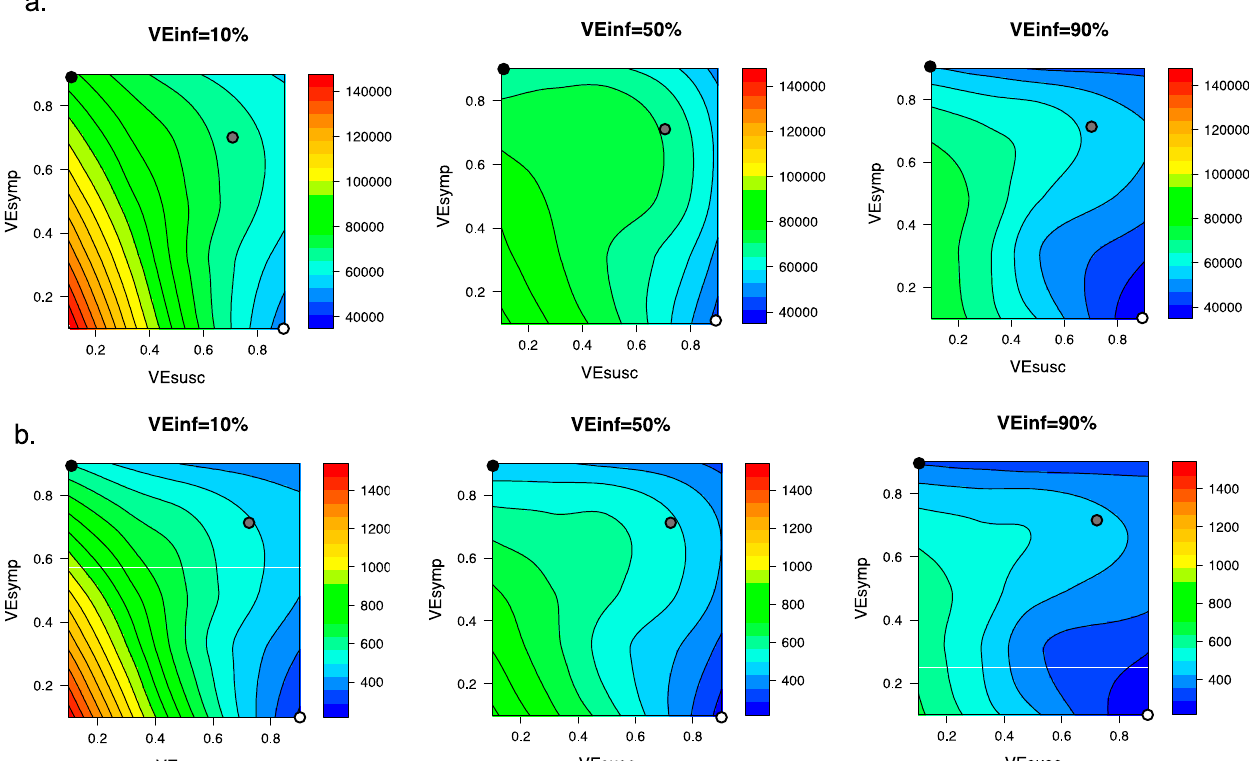
Figure 5. High VE INF further reduces diagnosed cases and death only when VE SUSC is low or moderate. Heat maps comparing contrasting vaccine scenarios. ( a ) Post-vaccine diagnosed cases (top row) which are approximately 25% of all infections and ( b ) post-vaccine deaths (bottom row) with different combinations of VE SUSC and VE SYMP . In this simulation, there were 66558 diagnosed cases and 1054 deaths prior to vaccination and heat maps capture all outcomes beyond this point. The left column assumes VE INF = 10%; middle column assumes VE INF = 50%; right column assumes VE INF = 90%. The dots are 3 scenarios compatible with results from the Pfizer and Moderna trials in which VE DIS = 90% (black is VE SYMP = 90%/VE SUSC = 0%, grey is VE SYMP = 70%/VE SUSC = 70% and white is VE SYMP = 0%/VE SUSC = 90%). Increased VE INF leads to a larger further reduction in cases when VE DIS is mediated by high VE SYMP than when it is mediated by high VE SUSC . In general, additional benefit of VE INF is accrued when VE SUSC is low, across a wide range of VE SYMP . 3.5. Vaccine Efficacy as a Determinant of Fourth Wave Severity Assuming Low Vaccination Rate